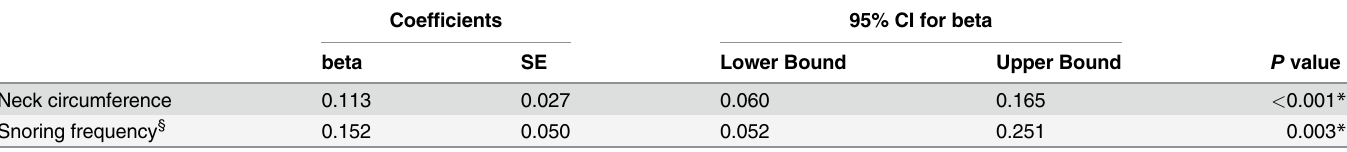
Table 5. Stepwise multiple linear regression results on the association with AHI.